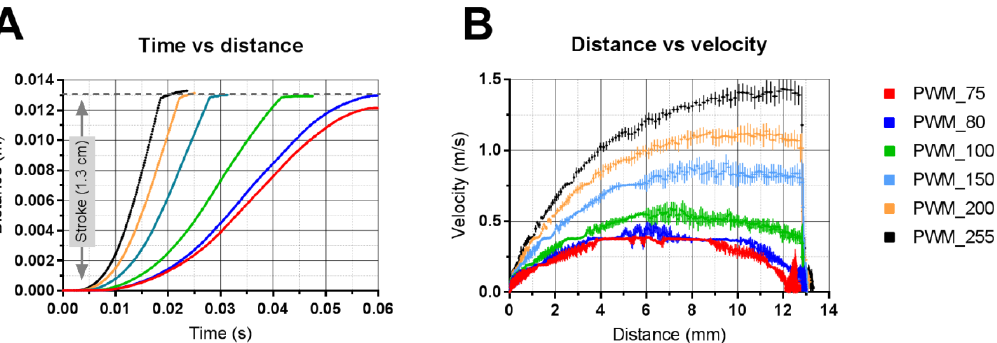
Figure 6. Analysis of high-speed imaging data (8000 fps) to determine the traveled distance ( A ) and the velocity as a function of the position of the microneedle mount at different pulse widths ( B ). Data are shown as mean ± SD, n = 10.